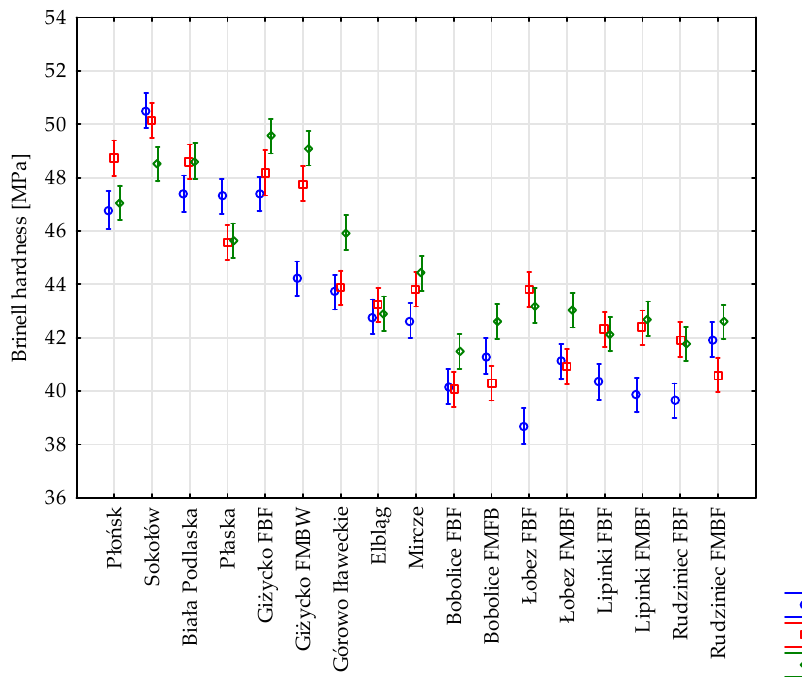
Figure 5. Mean wood hardness values and standard errors, for location and age.